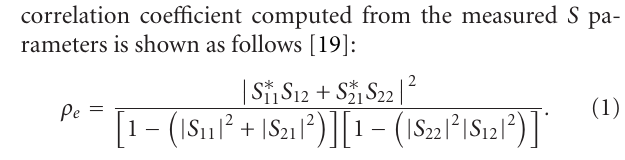
plane at 0.9, 1.9, and 2.5 GHz, respectively. The results also show that the radiation fields of the antenna 1 and antenna 2 are orthogonal. The discrepancy of the patterns between the two antennas is mainly caused by the manufactured and the measured aberration.